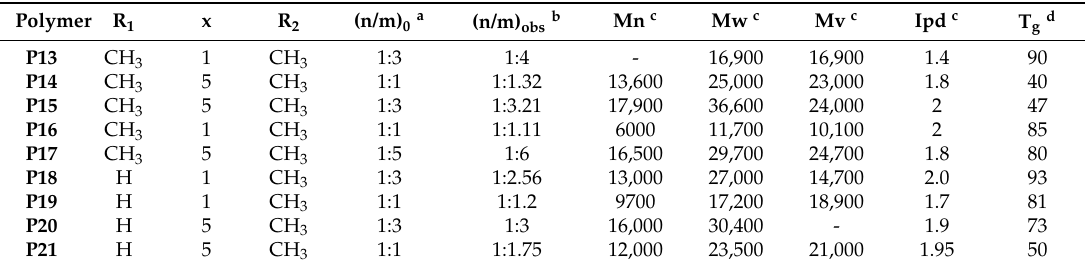
Table 2. Results of radical polymerization of 10% methacrylic ester monomers (case of monomers 3b , c and 4b , c (y = 1)) in DMF at 80 ° С (argon atmosphere, AIBN 1%). Polymer